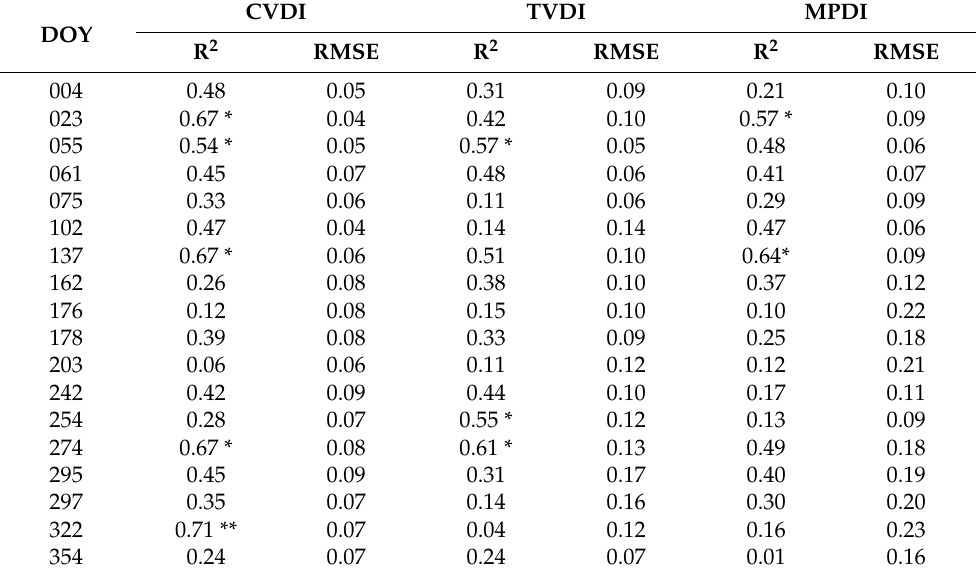
Table 3. Evaluation results between drought indices and SM for all of 18 days. CVDI TVDI DOY